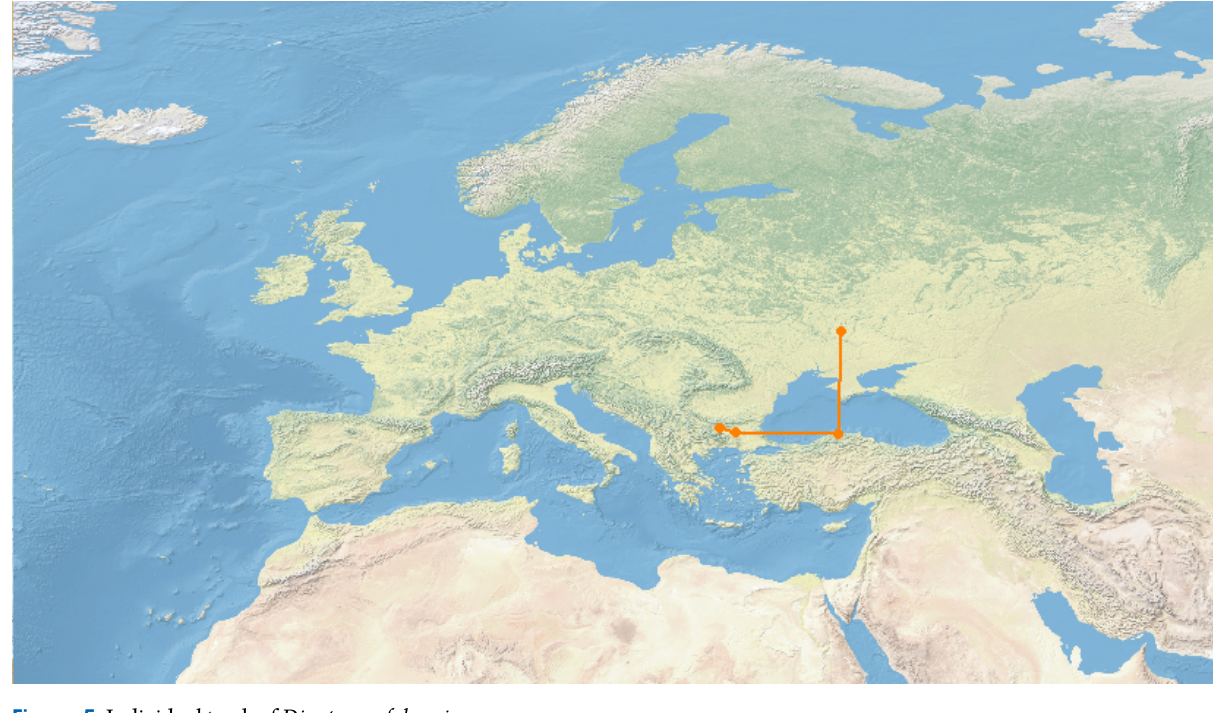
Figure 5. Individual track of Diaptomus falsomirus.